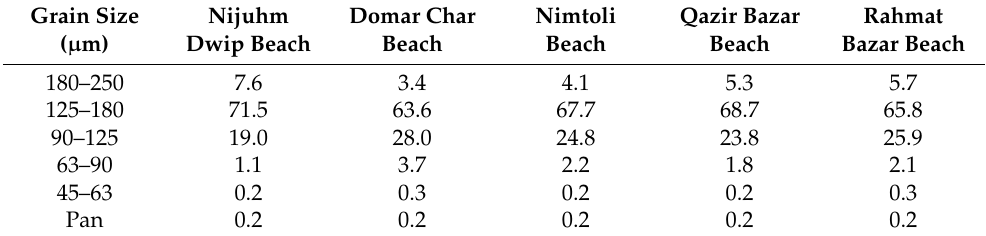
Table 1. Grain size distribution of the raw sand through the sieve analyzer.